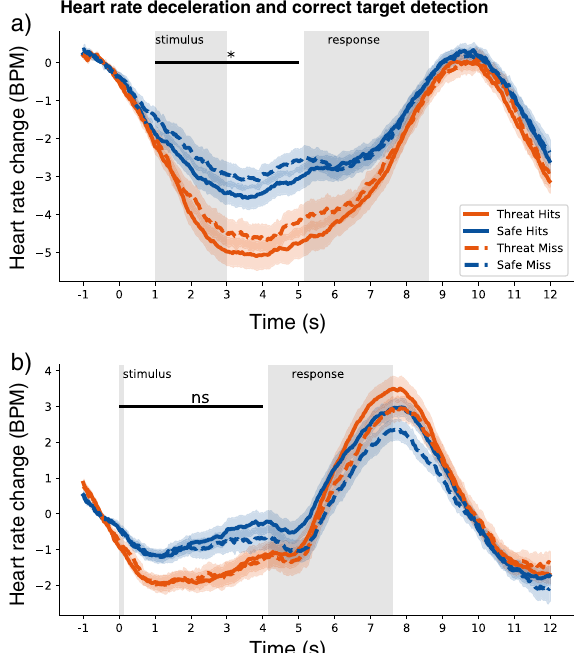
Figure 4. When aligned to the onset of the trial (which indicated the threat-of-shock or safe trial) there was an ( a ) increased heart rate deceleration for correctly identified targets versus missed targets for both threat-of- shock and safe trials. This significant difference was not present ( b ) when heart rate was aligned to the target onset. Shaded area represents standard error of the mean (SEM).